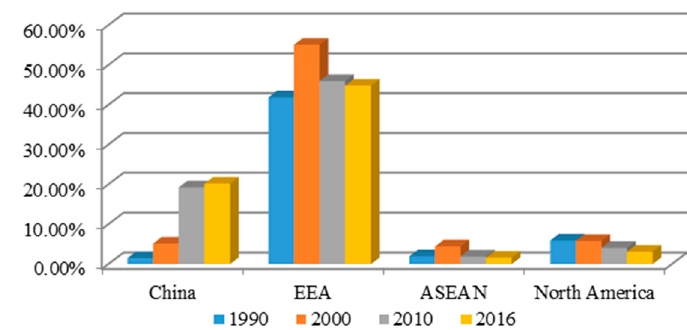
Figure 1. UK textile materials imports from regions as a percentage of total textile imports (%). Source: UN ComTrade SITC Rev. 3, 2017.